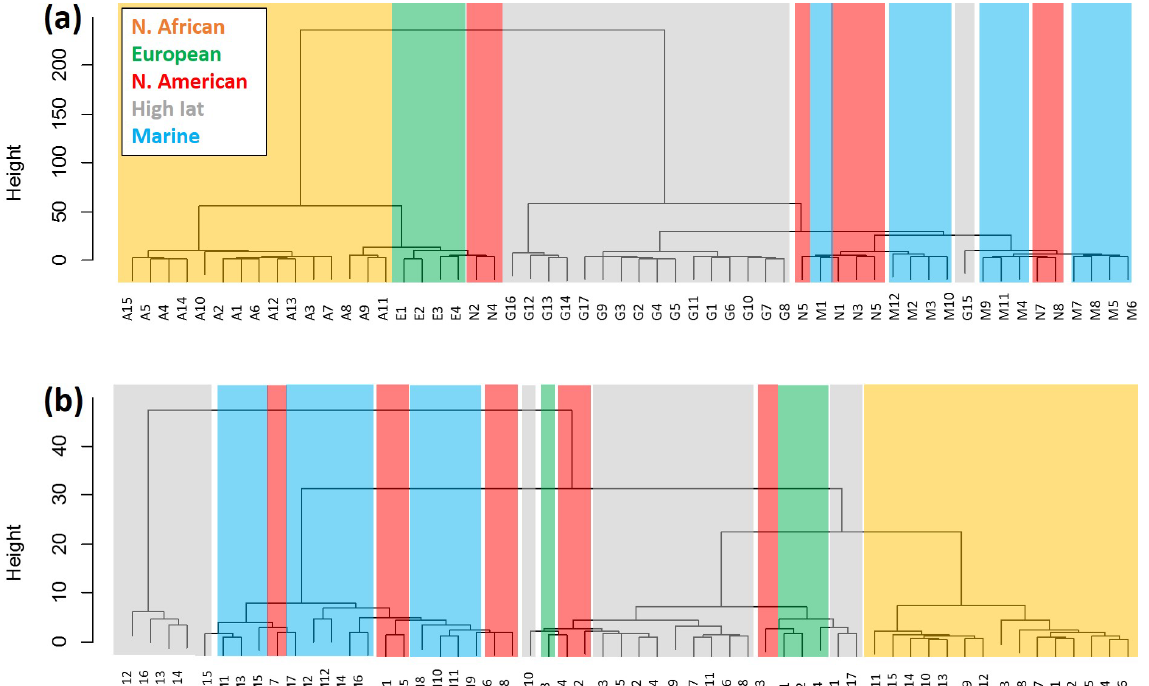
Figure 7. Hierarchical cluster analysis of (a) log-transformed total TE concentration data plus NO − transformed fractional solubility following the two-step sequential leach (fractional solubility calculated using Eq. 2) plus NO − data. The coloured blocks correspond to the aerosol source regions shown in the legend (note that the North African samples correspond to the yellow blocks of